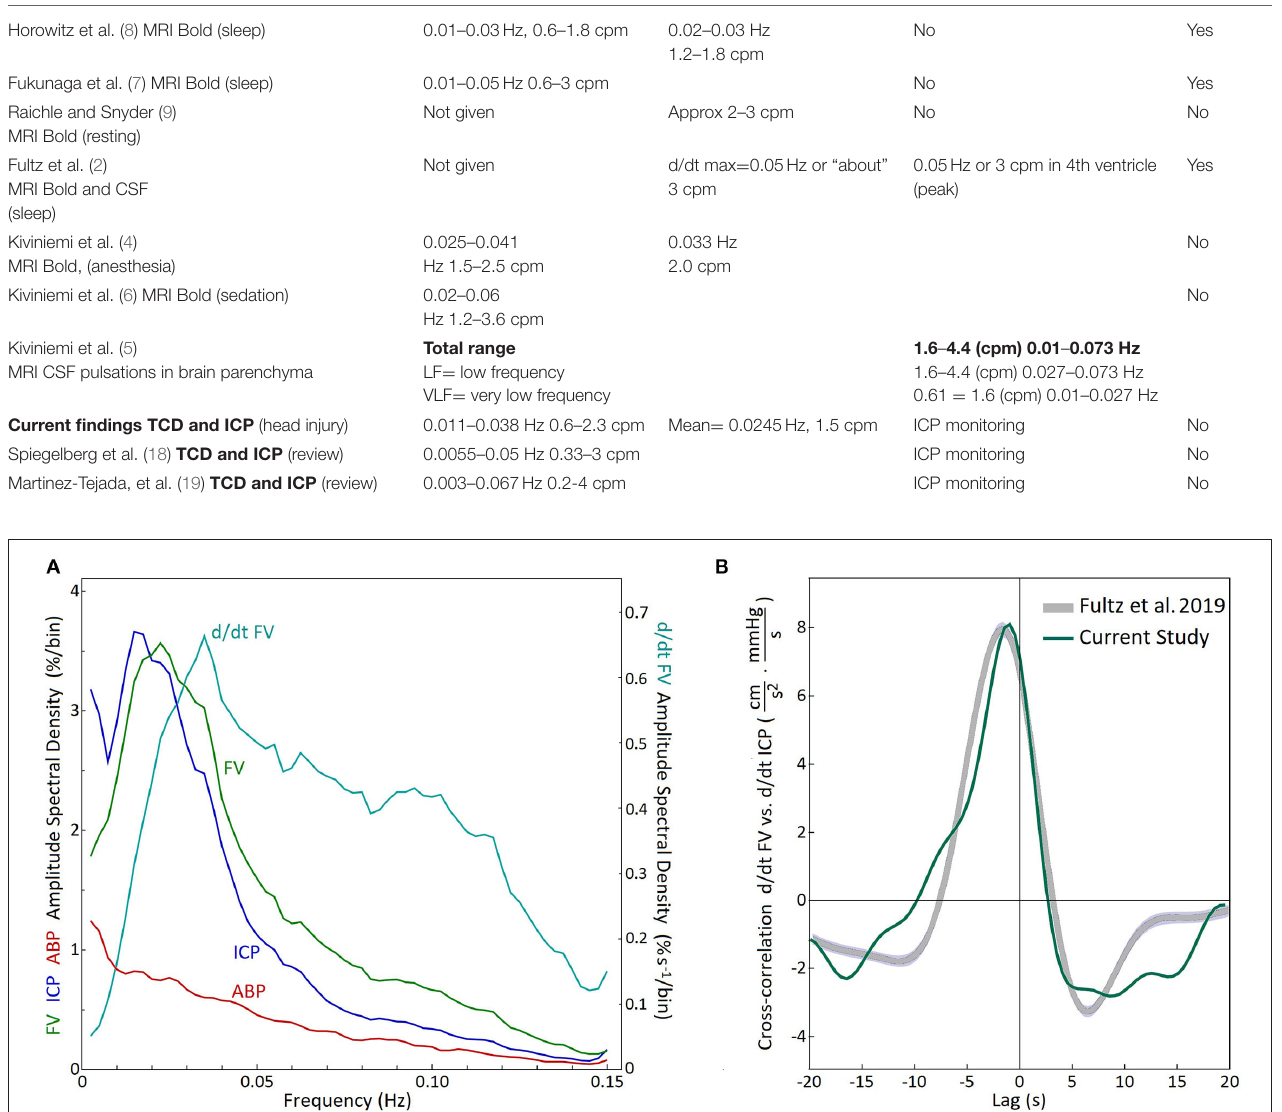
FIGURE 3 | Analysis of recordings of the patient group with high B wave activity. (A) Composite of discrete Fourier transform spectral analysis of 31 recordings with high B wave activity (B wave amplitude above 10% of mFV) in 13 patients. The composite amplitude spectral density was calculated as the square roots of the averaged power spectral densities for each frequency bin. Maximum spectral density was found at 0.0225Hz for the FV and 0.0175Hz for the ICP. The time derivative for the FV had a maximum amplitude at 0.035Hz (d/dt FV) FV, flow velocity; ICP, intracranial pressure; ABP, arterial blood pressure. (B) Composite cross-correlation of d/dt FV vs. d/dt ICP for the same 31 recordings (Green). The gray curve shows the cross-correlation (-d/dt BOLD vs. CSF movement) reported by Fultz et al. (2) during sleep in normal subjects. (The curves share same zero line and the arbitrary units used for the MRI data have been scaled to facilitate comparison.)